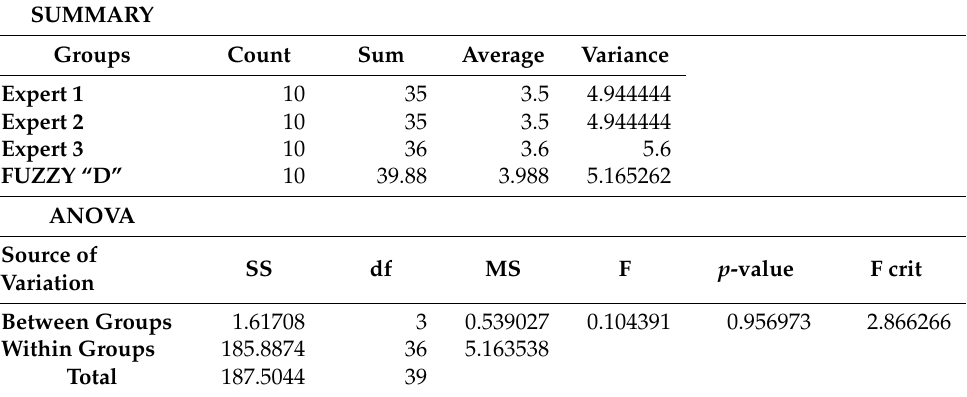
Table 7. ANOVA: single Factor for fuzzy